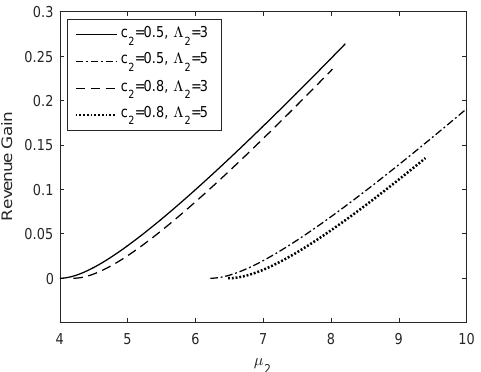
Figure 3. Revenue gain of the collaboration when µ 2 < µ 2 ≤ µ 2 . ( V = 2.5, c 1 = 1, µ 1 = 10, Λ = 12, α = β = 0.5, Revenue gain ratio: ∇ π = ( (cid:79) π 1